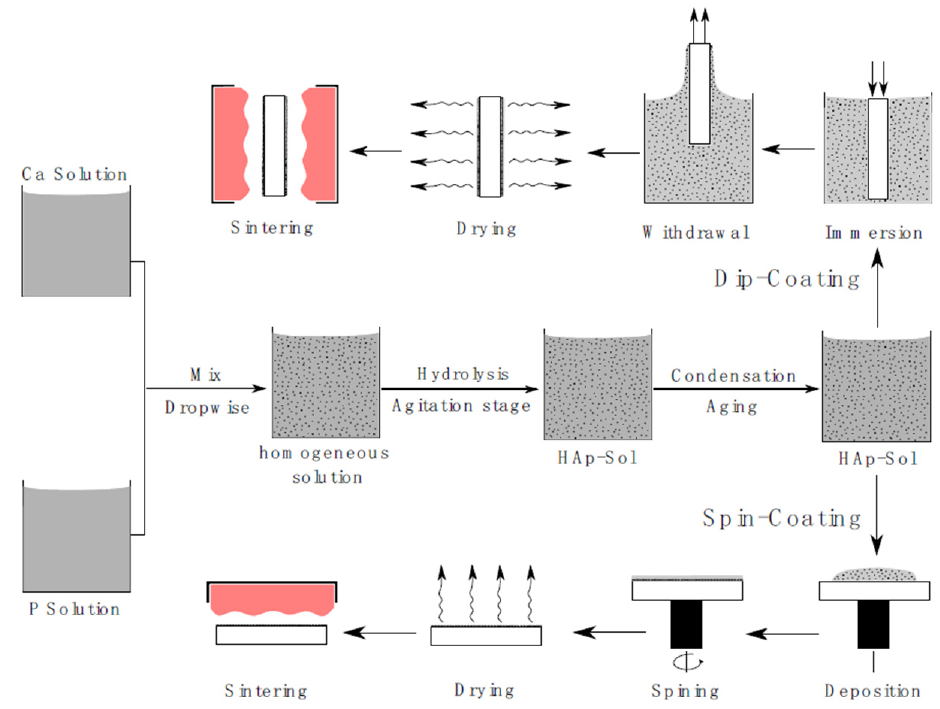
Figure 2. The fundamental stages of sol-gel HAp preparation and deposition by dip and spin coating [109].